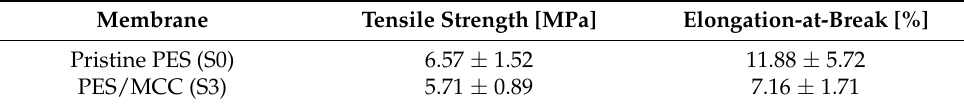
Figure 7. Stress–strain behavior of pristine PES and PES/MCC composite membranes at room temperature. Table 2. Average tensile strength and elongation-at-break for pristine PES and PES/MCC composite membranes.